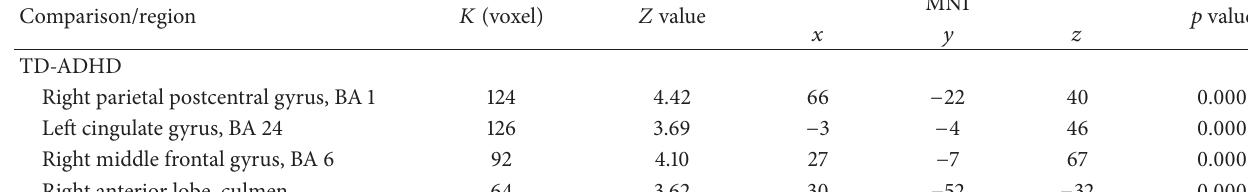
Right parietal postcentral gyrus, BA